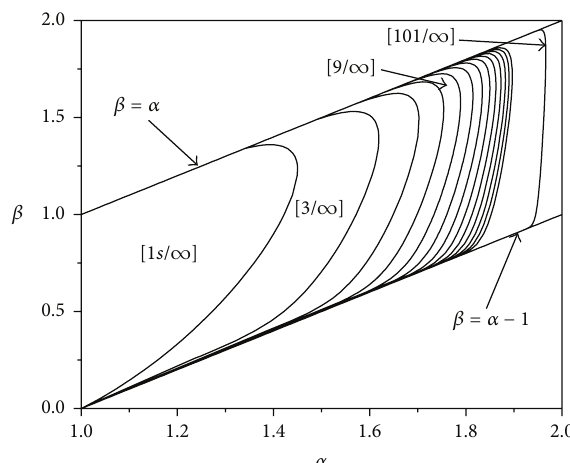
Figure 6: Typical Mittag-Leffler function in [ 𝑓/∞ ].